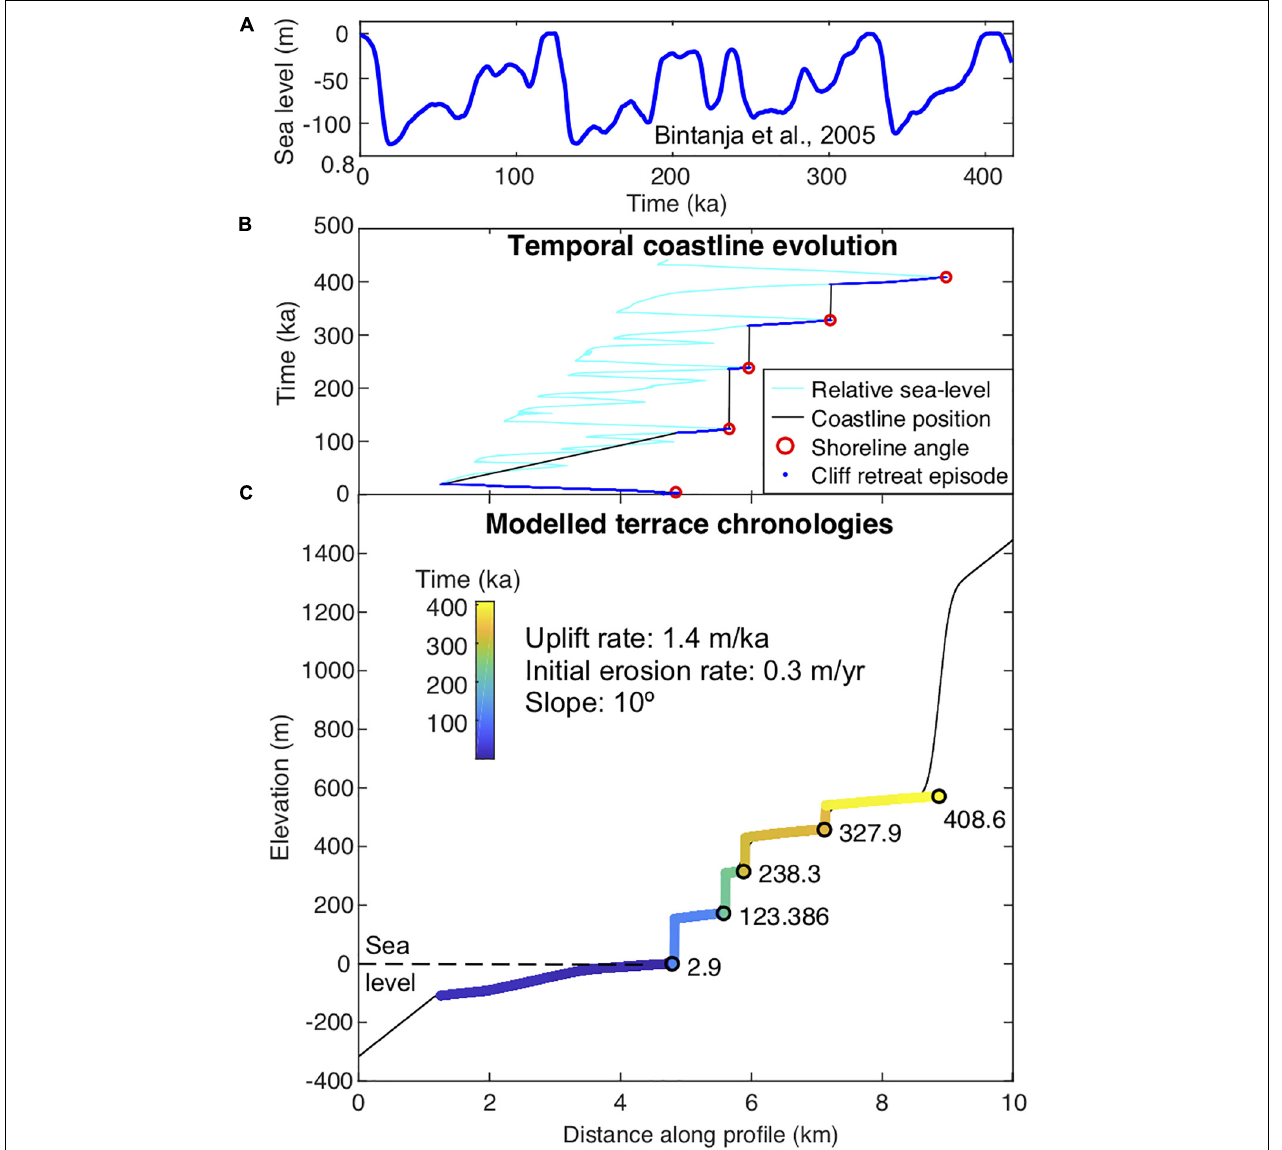
FIGURE 6 | Example of LEM results. (A) Input sea-level curve. (B) Modeled temporal coastline evolution. (C) Modeled terrace topography color coded by age, for an uplift rate of 1.4 m/ka, initial erosion rate (E0) of 0.3 m/yr, and initial slope of 10 ◦